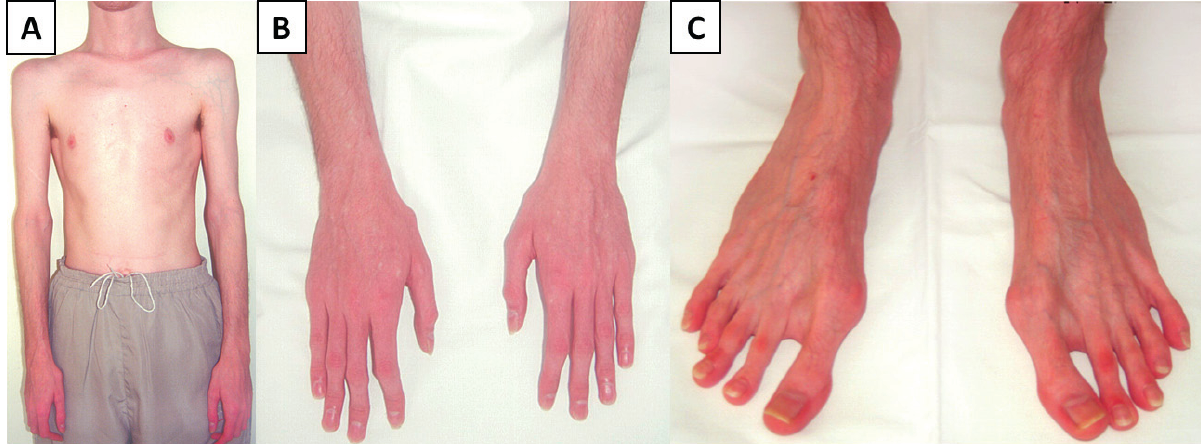
Fig. 2. Physical appearance of the patient with brittle cornea syndrome. (A) asthenic habitus (age 26); (B) hands with clinodactyly (age 26); (C) feet with hallux valgus (age